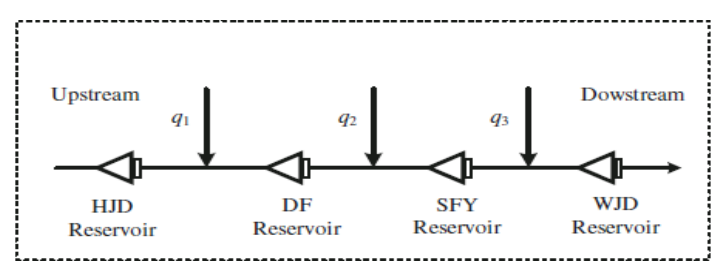
Figure 2. The Wujiang multi-hydropower reservoirs (HJD, DF, SFY, and WJD).